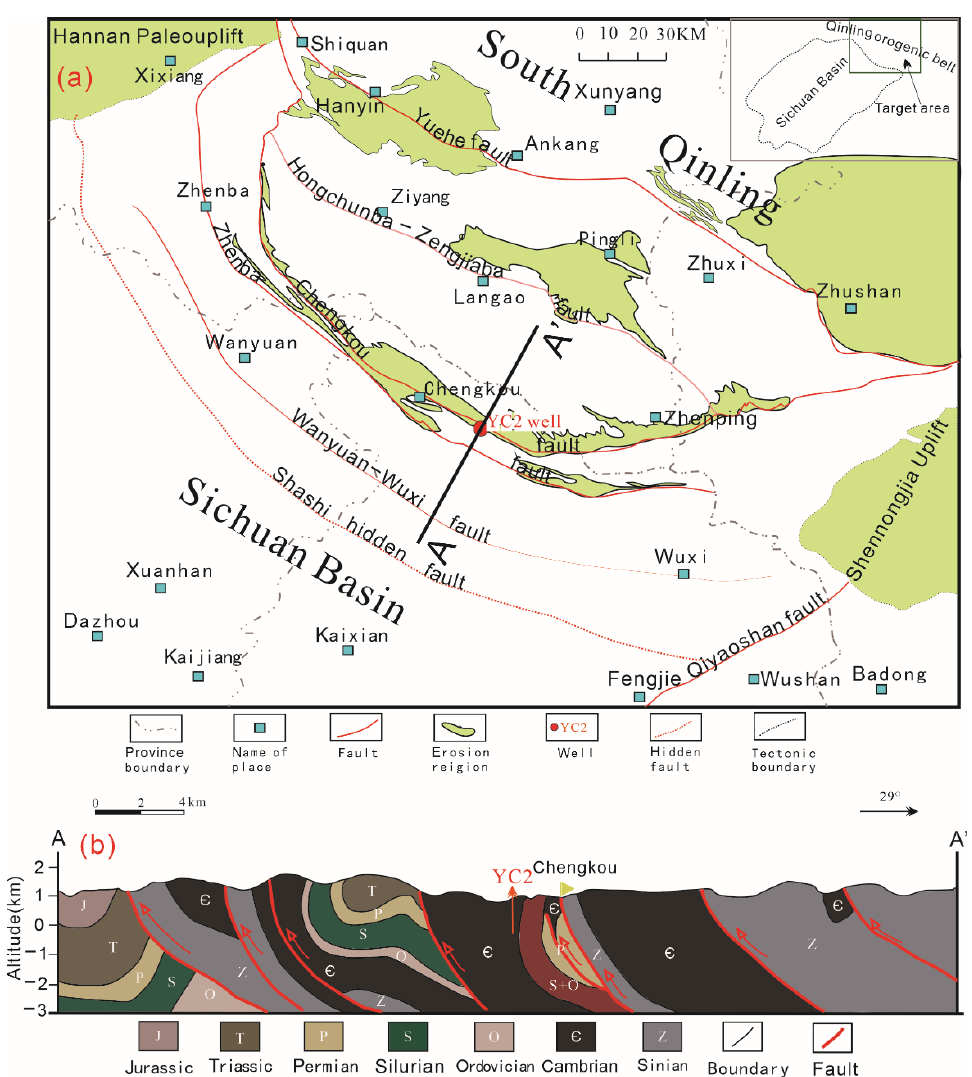
Figure 1. Schematic map to show the geological outline of the Dabashan tectonic belt ( a ) and a profile to pass through the tectonic belt ( b ). ( a , b ) were modified from Yu et al. [19] and Ma et al. [36], respectively.